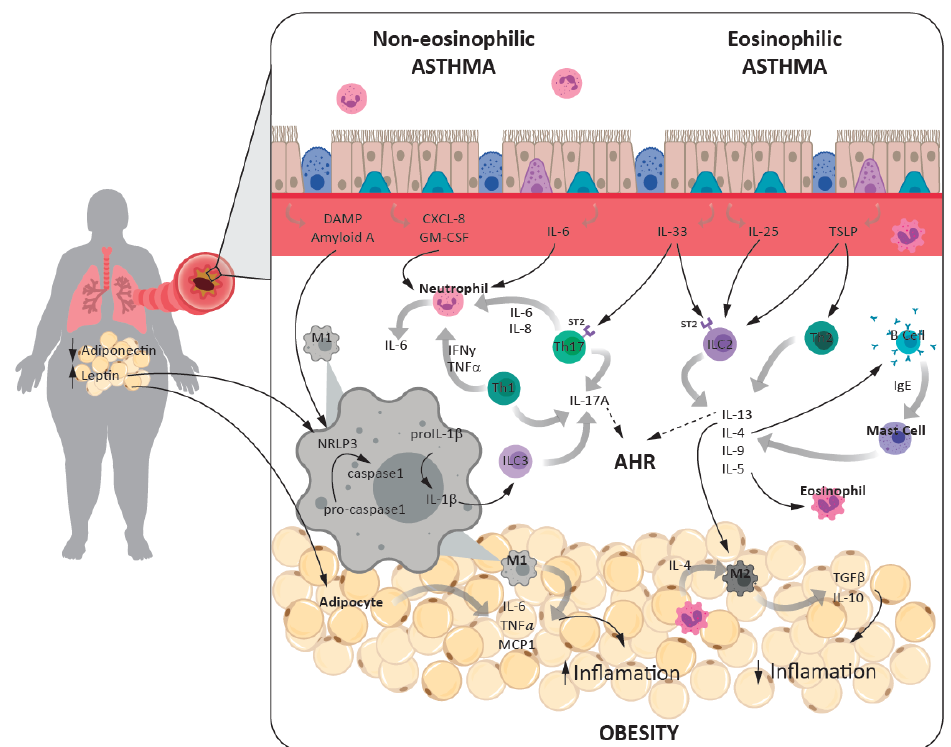
Figure 1. Interrelationship between the inflammatory processes that account for the asthma-obesity phenotype. Eosinophilic asthma is triggered by type 2 inflammation where Th2, ILC2, and type 2 cytokines are involved. This could be allergic (when immunoglobulin E (IgE) is present) or non-allergic. Non-eosinophilic asthma (neutrophils are present in the airway lumen) is mediated by type 1 inflammation and Th1, Th17, and ILC3 release type 1 cytokines. Inflammation in obesity is due to the imbalance of adipokines. Leptin stimulates adipocytes to release inflammatory mediators and activates M1 macrophages intracellular multiprotein complex, NLRP3. The activation of NLRP3 in M1 macrophages resident on adipose tissue and in the lungs, resulting in an amplification in IL-1 β production, the subsequent ILC3 activation, and IL-17 secretion, which in turn facilitates airway hyperresponsiveness (AHR) in patients. In obesity, pro-inflammatory cytokines such IL-1 β , IL-6, and TNF α contribute to asthma pathogenesis. In contrast, cytokines that are pro-inflammatory in asthma such as IL-4, IL-13, and IL-33 contribute to maintain the lean state through the activation of anti-inflammatory M2